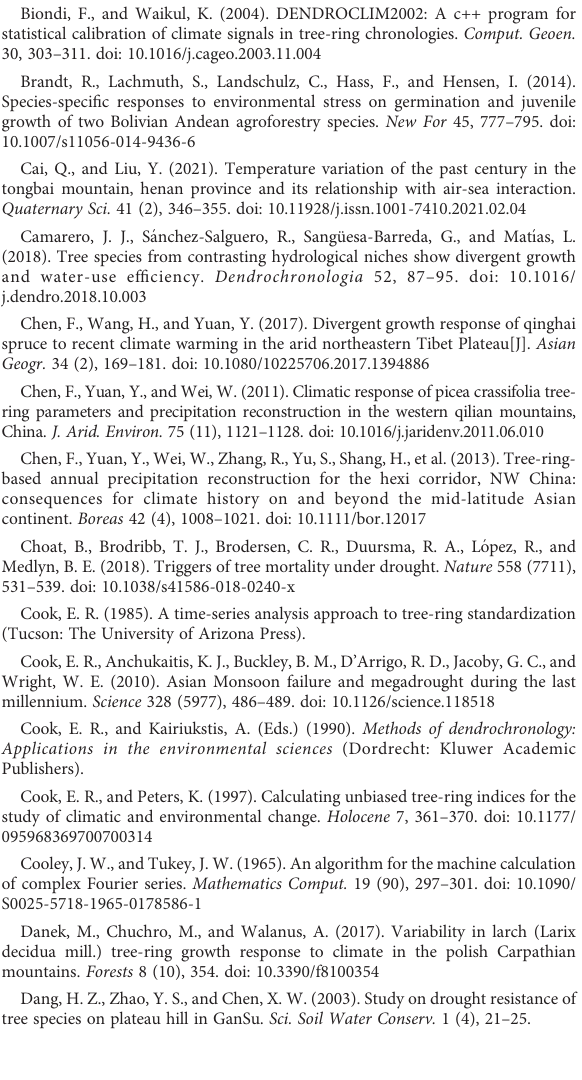
SUPPLEMENTARY TABLE 2 Correlation matrix between different pairs of fi ve standard chronologies during the common period 1907-2014. SUPPLEMENTARY TABLE 3 Correlation matrix between different pairs of fi ve residual chronologies during the common period